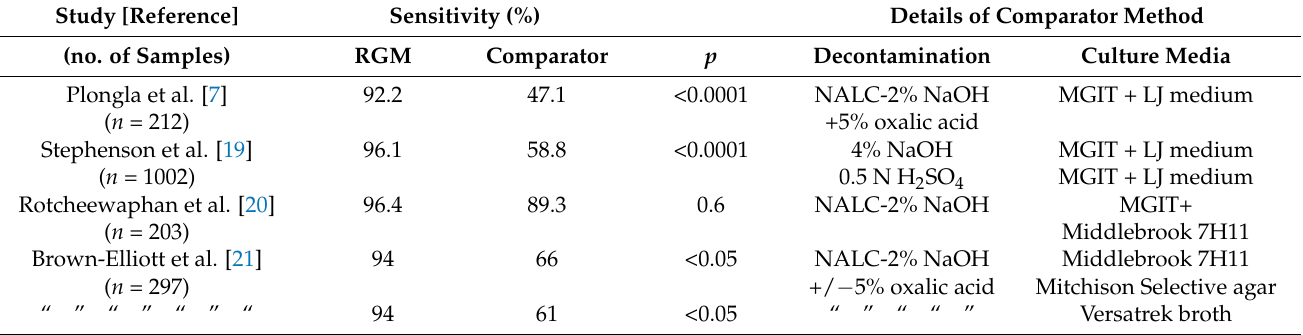
Table 2. A comparison of direct culture on RGM medium with AFB culture of decontaminated samples for isolation of MABSC from respiratory